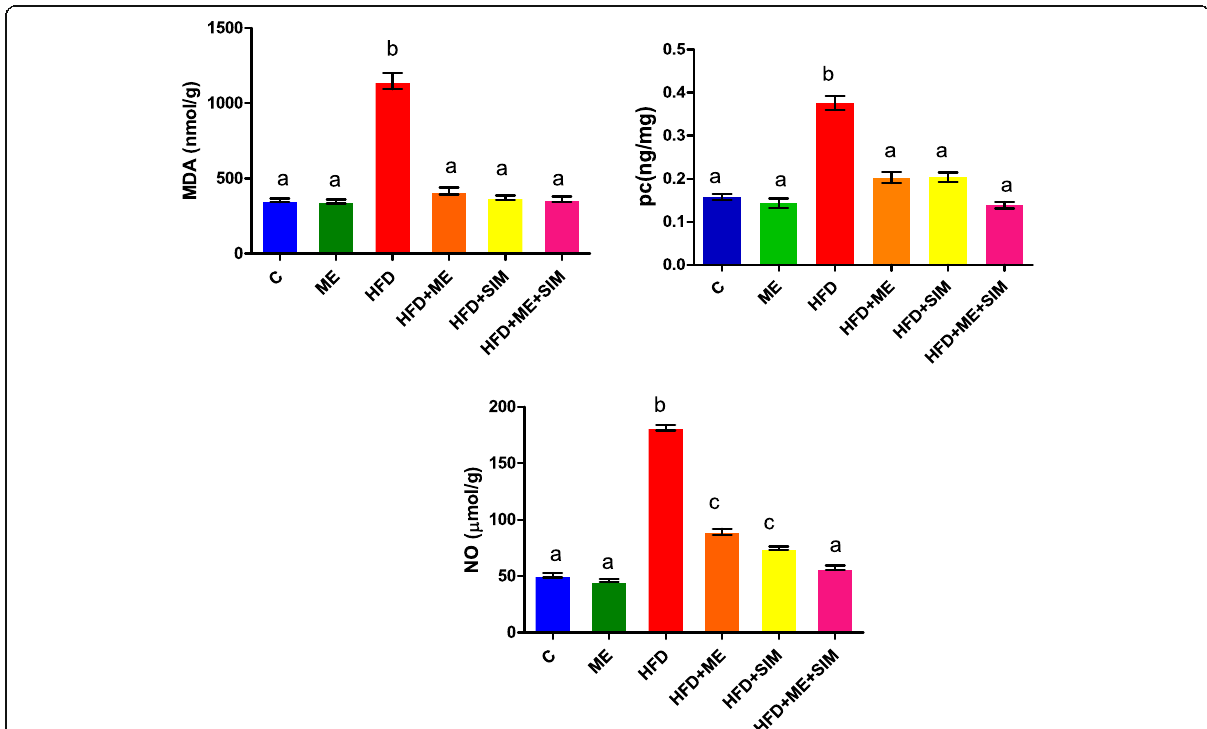
Fig. 5 The effects of Moringa leaf extract (ME), simvastatin (SIM) and their combination (ME+SIM) on the levels of lipid peroxidation (as indicated by malondialdehyde (MDA)), protein oxidation (represented by protein carbonyl (PO)) and nitric oxide (NO) in the livers of rats fed a high-fat diet (HFD) for 6 weeks. ME protected liver tissue as indicated by the maintenance of comparable activities to the control. Different letters indicate significant differences between groups (p < 0.05). Values are means ±SD (n =